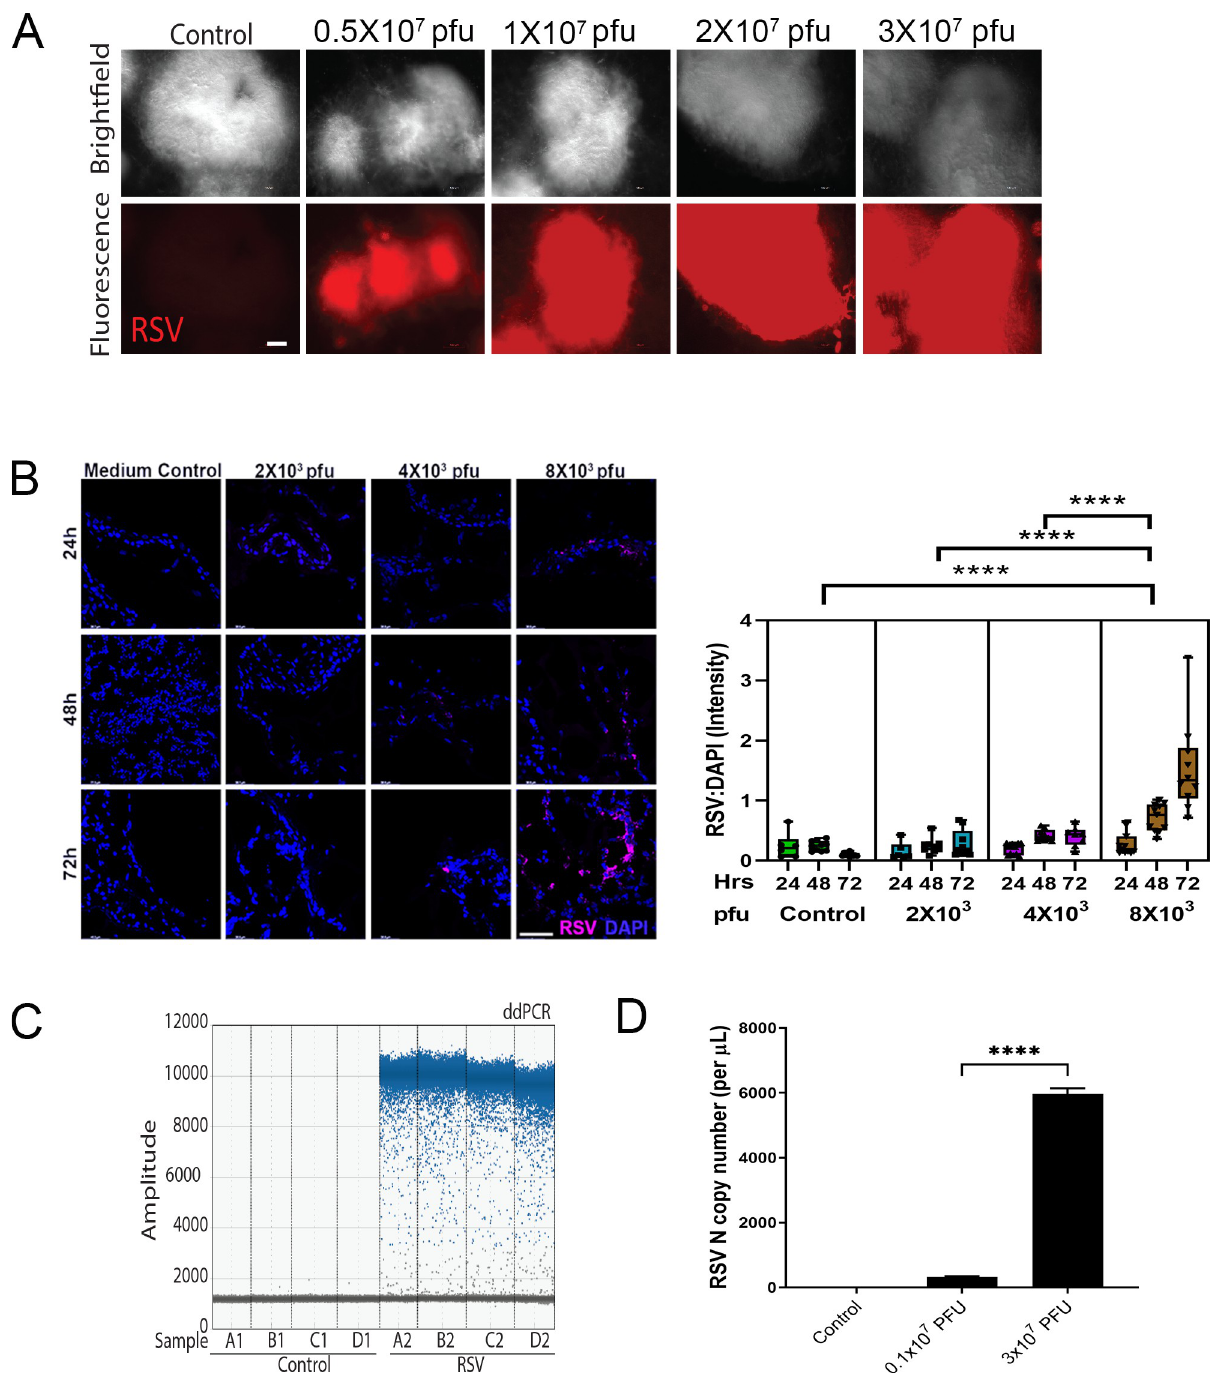
Fig 2. Dose-dependent RSV infection of HLOs. Increasing volumes of rrRSV suspension (10 7 pfu/ml) or sterile medium were used to infect HLOs using a microinjector system. (A) Red fluorescence was expressed 5 days after inoculation by the replication of rrRSV in a dose-dependent manner. (B) After inoculation of control sterile medium or increased amounts of rrRSV suspension (10 7 pfu/ml) into the of HLOs lumen, little infection was noted at 24 h, whereas increasing infectivity was noted at 48 and 72 hours post-infection. (C) ddPCR detection of viral RNA in culture medium. (D) copy number of RSV nucleocapsid (N) genes in culture medium, confirming a dose-dependent infection.